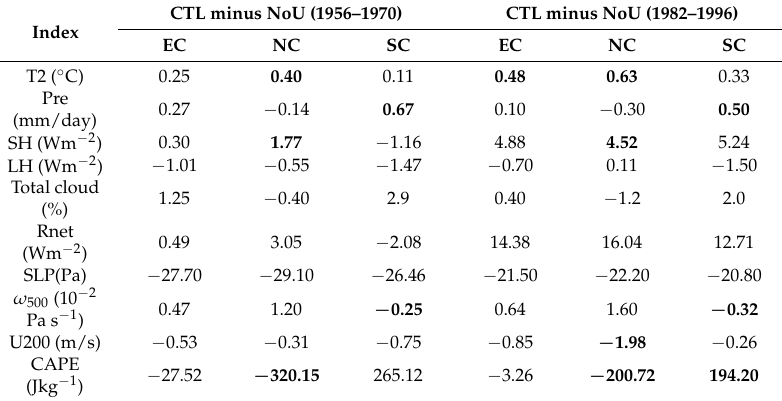
Figure 6. Possible mechanism of urbanization impact on climate based on different PDO phases. Left column: 1982–1996; right column: 1956–1970. ( a , b ) show the surface wind of difference between CTL_P and NoU_P, and CTL_N and NoU_N, respectively. ( c – h ) show vertical-meridional cross-sections of the difference between CTL_P and NoU_P, and CTL_N and NoU_N, respectively. ( c , d ) show adiabatic heating of dry air (shading; K day − 1 ). ( e , f ) show temperature (shading; ◦ C), specific humidity (contour; g/kg) and vertical velocity (vector; revealed by (v, − ω ), where v (m s − 1 ) is meridional velocity and – ω (10 − 2 Pa s − 1 ) represents vertical pressure velocity) averaged over 110 ◦ –122 ◦ E. ( g , h ) show the difference field between CTL and NOURBAN of zonal wind (shading; m/s) and climatological zonal wind which is averaged over 110 ◦ –122 ◦ E. Above 90% confidence level of wind speed has been shaded. The stippled area shows above 90% confidence level of adiabatic heating of dry air, ω , and zonal velocity. The slash lines show above 90% confidence level of temperature. The horizontal lines show above 90% confidence level of specific humidity. Table 3. Changes in EASM-relevant quantities that are influenced by urban land use: surface air temperature at 2-m (T2); precipitation (Pre); sensible (SH) and latent heat (LH) fluxes; total cloud; surface net radiation (Rnet); sea level pressure (SLP); vertical velocity on 500 hPa ( ω 500 ); zonal wind on 200 hPa (U200); and convective available potential energy (CAPE). Their differences between the experiments were averaged over EC (20–45 ◦ N, 105–122 ◦ E), NC (32.5–45 ◦ N, 105–122 ◦ E), and SC (20–32.5 ◦ N, 105–122 ◦ E). The numbers in boldface are statistically significant at the 10%